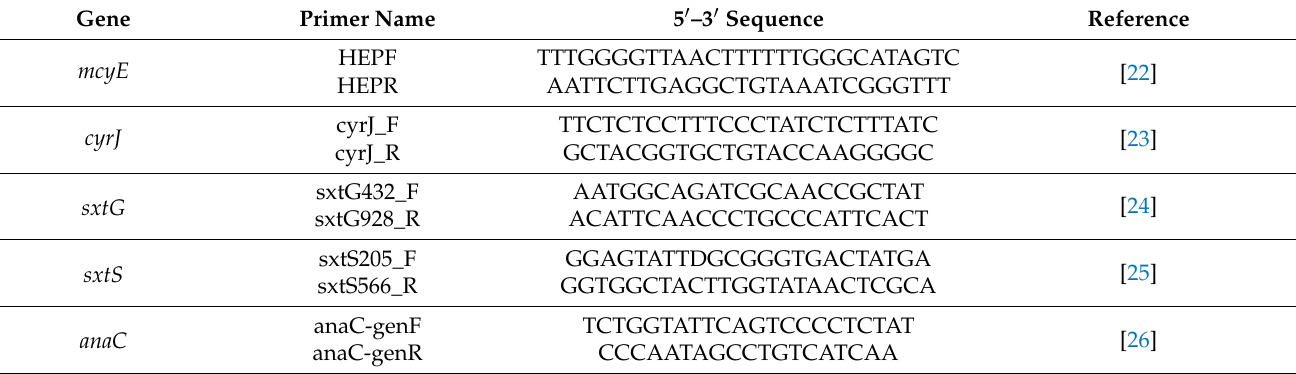
Table 2. Primers used for the qualitative PCR for detecting the presence of microcystin (MC; mcyE ), cylindrospermopsin (CYN; cyrJ ), saxitoxin (STX; sxtG , sxtS ) and anatoxin (ATX; anaC ) coding genes.